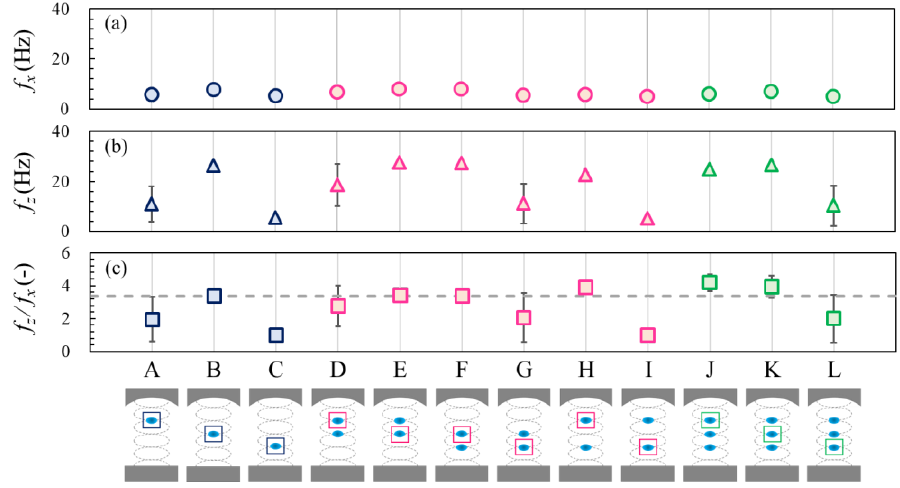
Figure 6. FFT results for all cases. The primary frequency for the ( a ) horizontal and ( b ) vertical oscillations. ( c ) Frequency ratio for each case. The average values were used for each plot, and the error bars represent the standard deviations of the three experiments. The dashed line represents the calculated value in a previous study. Data from [18].